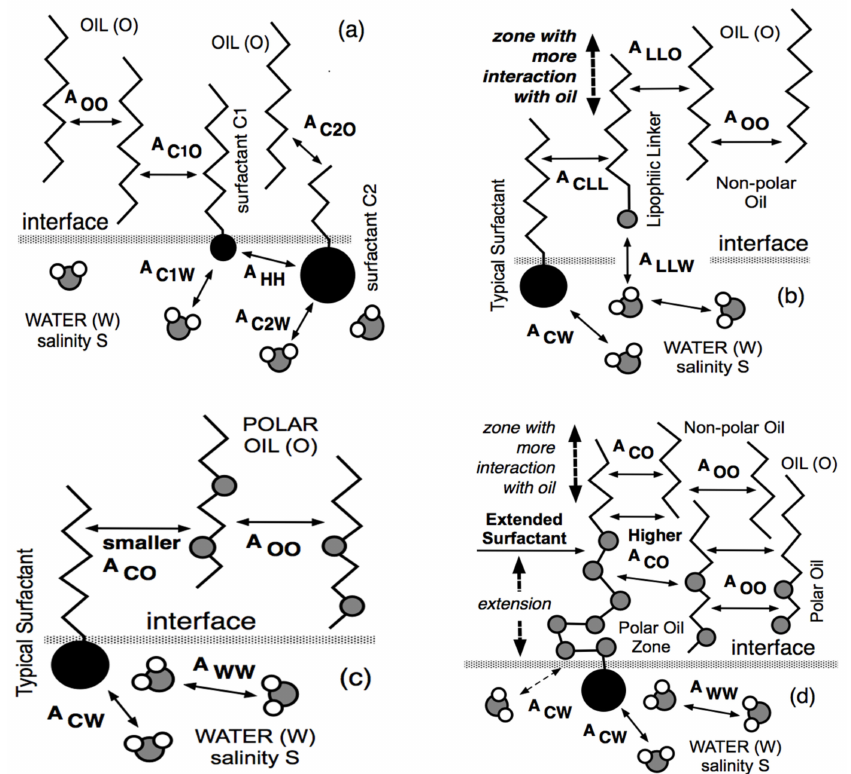
Figure 5. Interfacial arrangements ( a ) with two ordinary surfactants C1 and C1, ( b ) with a surfactant and a lipophilic linker, ( c ) with an ordinary surfactant and a polar oil, and ( d ) with an extended surfactant and a polar